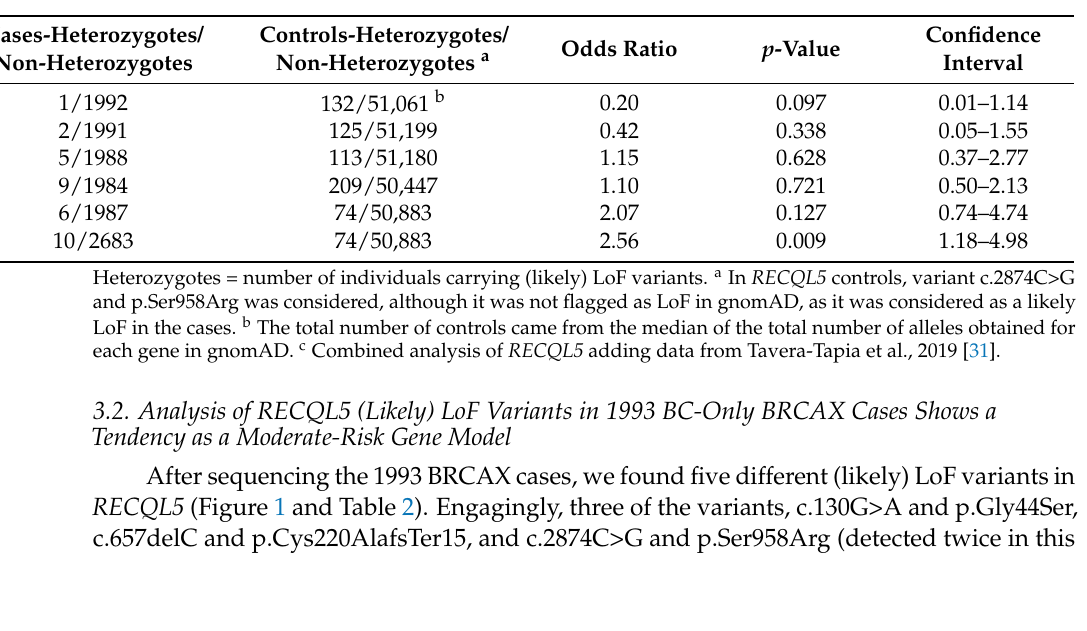
Table 3. Cases-control analysis of the variants found in the five helicase genes